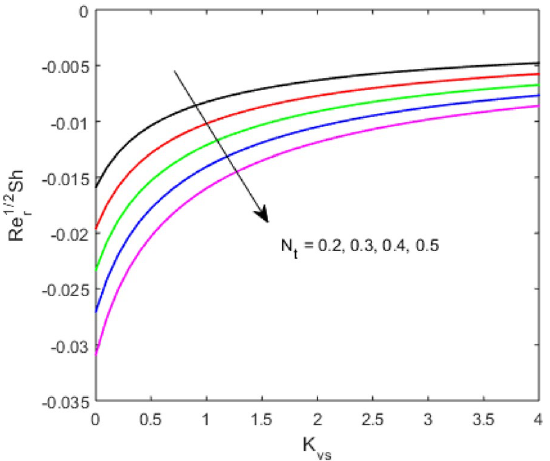
Figure 13. Sherwood number ( Re r ) − 1 / 2 Sh versus K vs for varing N t .